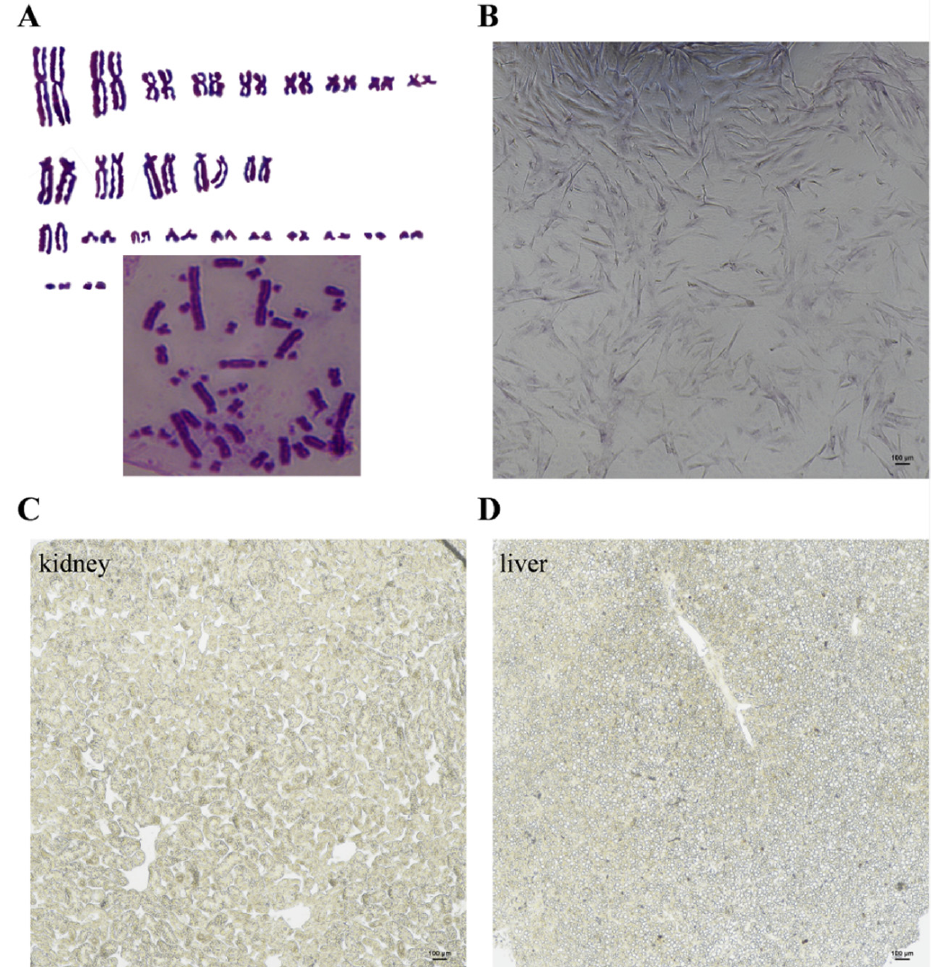
Figure 2. Karyotype analysis and alkaline phosphatase activity of YTO2 cells. ( A ) Karyotype analysis of the cultured ovarian cells in the Asian yellow pond turtle. Chromosomes were stained by Giemsa solution. Normal female karyotype (2n = 52) was presented in fGSCs. The lower right corner represents the original image of the chromosome. ( B ) The alkaline phosphatase activity was assessed in YTO2 cells at 20th passage. Scale bar, 100 µ m. ( C ) The alkaline phosphatase activity detection of kidney cells. Scale bar, 100 µ m. ( D ) The alkaline phosphatase activity detection of liver cells. Scale bar, 100 µ